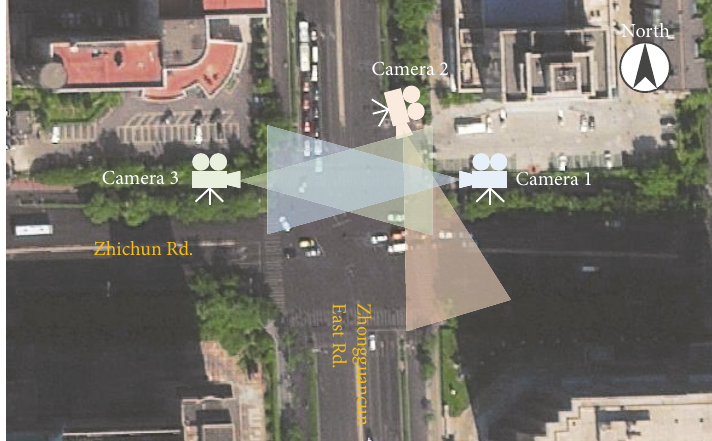
Figure 2: The intersection layout, camera locations, and camera shooting directions at Zhongguancun East Rd.-Zhichun Rd. intersection.